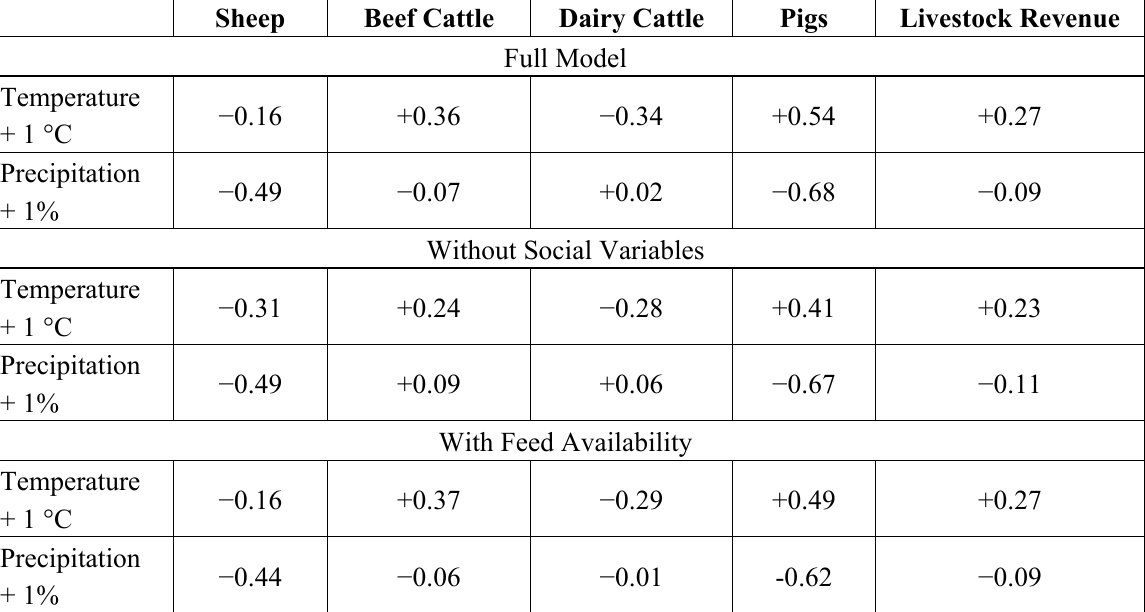
Table 7. Marginal effects and